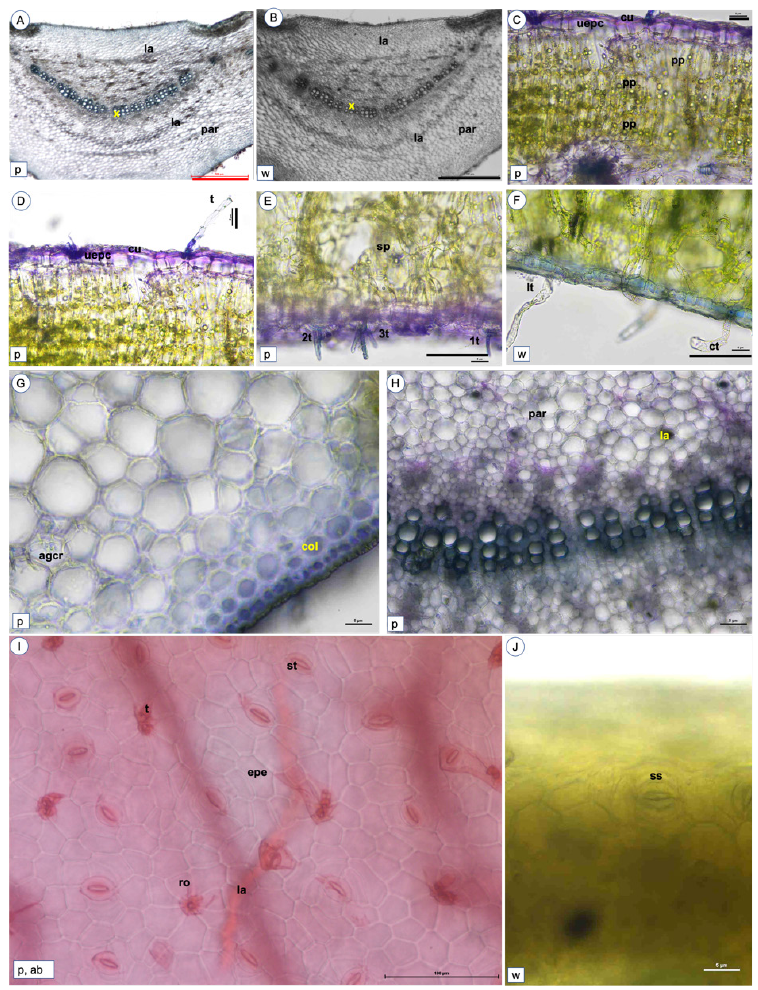
Figure 2 : LM and SEM of leaf anatomy of the two flower colour forms of Calotropis gigantea . (A) TS of a leaf of purple form. (B) white form along with the leaf bundle, similar structure to purple form. (c) three-storied palisade parenchyma. (D) thick cuticle with multicellular trichomes. (E) abaxial surface showing different types of trichomes. (F) abaxial surface showing leafy shape, multicellular or curved trichomes. (G) the lower surface of the leaf showing a thick cuticle and a few layers of collenchyma. (H) vascular tissues of purple form. (I) after leaf clearing and stained with safranin, stomata arrangement of the abaxial surface of the purple leaf and different shapes of epidermal pavement cells and stomata. (J) sunken stomata on the adaxial surface. Sub-figure letters: p: purple. w: